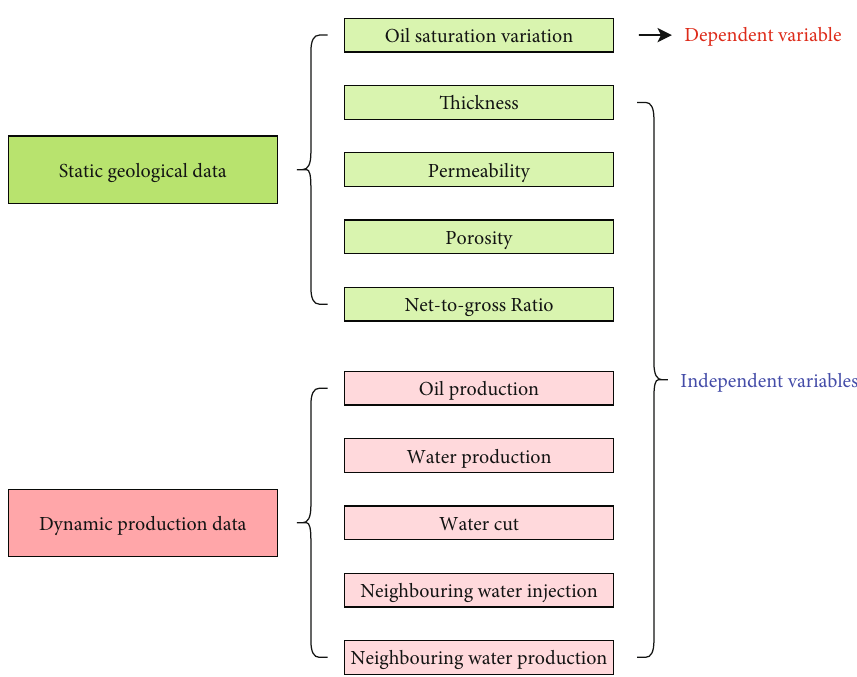
Figure 2: Diagram of neighbouring wells and neighbouring relationship.